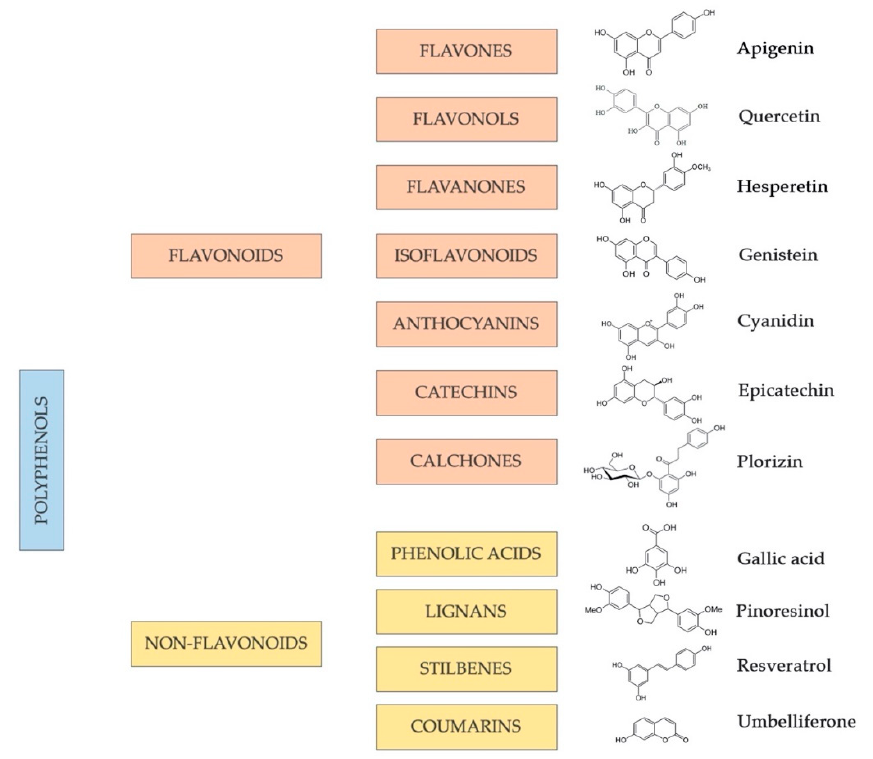
Figure 3. Phenolic compound scheme: classes, sub-classes, and molecular structure of a typical compound of each sub-class.